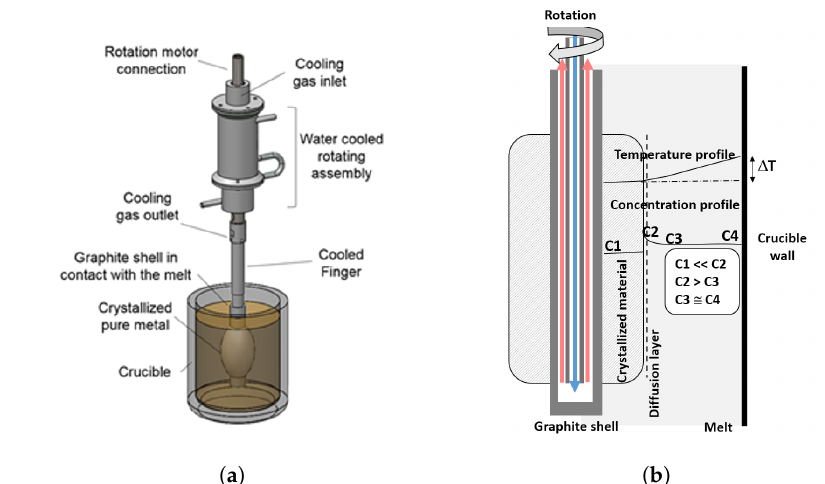
Figure 1. ( a ) Simplified sketch and ( b ) the process schematics of a cooled finger fractional crystallization